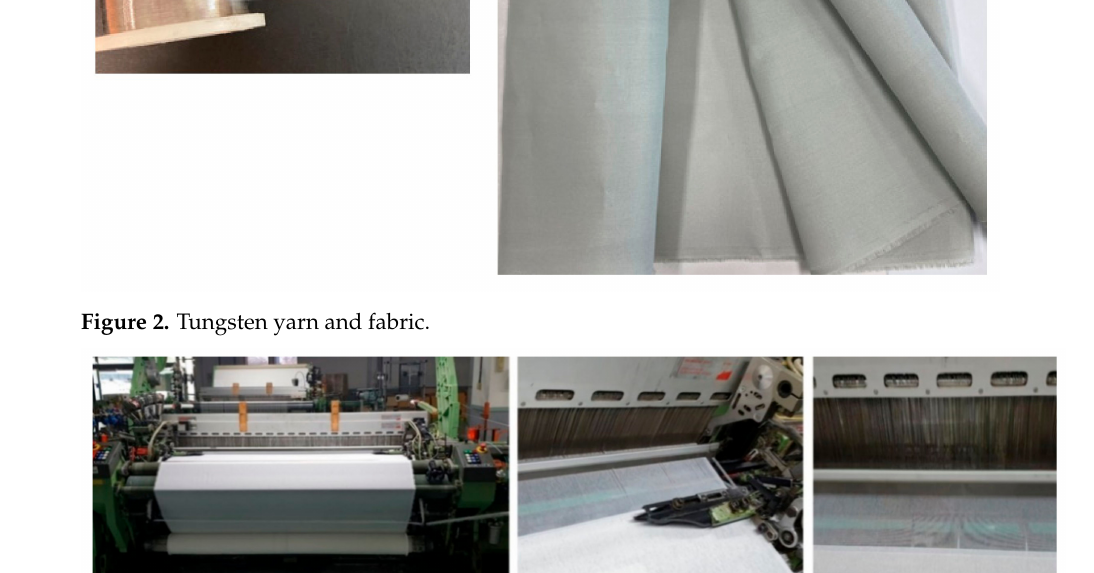
Figure 3. High-density weaving process of shielding